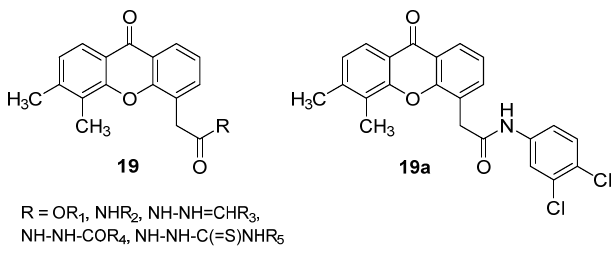
Figure 14. Carboxylic acid derivatives of DMXAA.